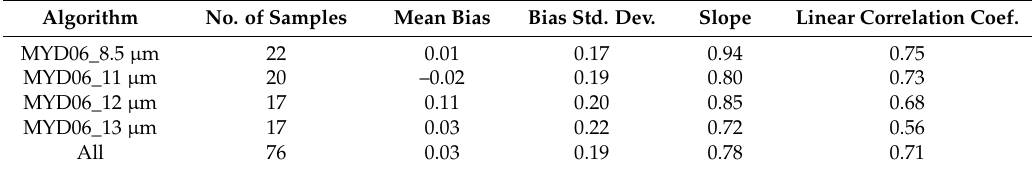
Figure 7. Difference between cloud effective emissivities observed by MODIS/AQUA and the ground-based joint instrument. Table 1. Statistics of the comparison of the cloud effective emissivities shown in Figure 7: the mean bias, the std. dev. of the mean bias, the slope of a best-fit linear regression line, and the linear correlation coefficient values between the satellite- and ground-based retrievals.